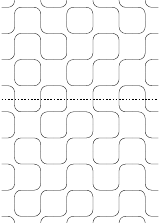
¥ cylinder, periodic in the horizontal direction loop model on a 6 (cid:2) (cid:3) (cid:0)(cid:2) (cid:0)(cid:0)(cid:2) (cid:2)